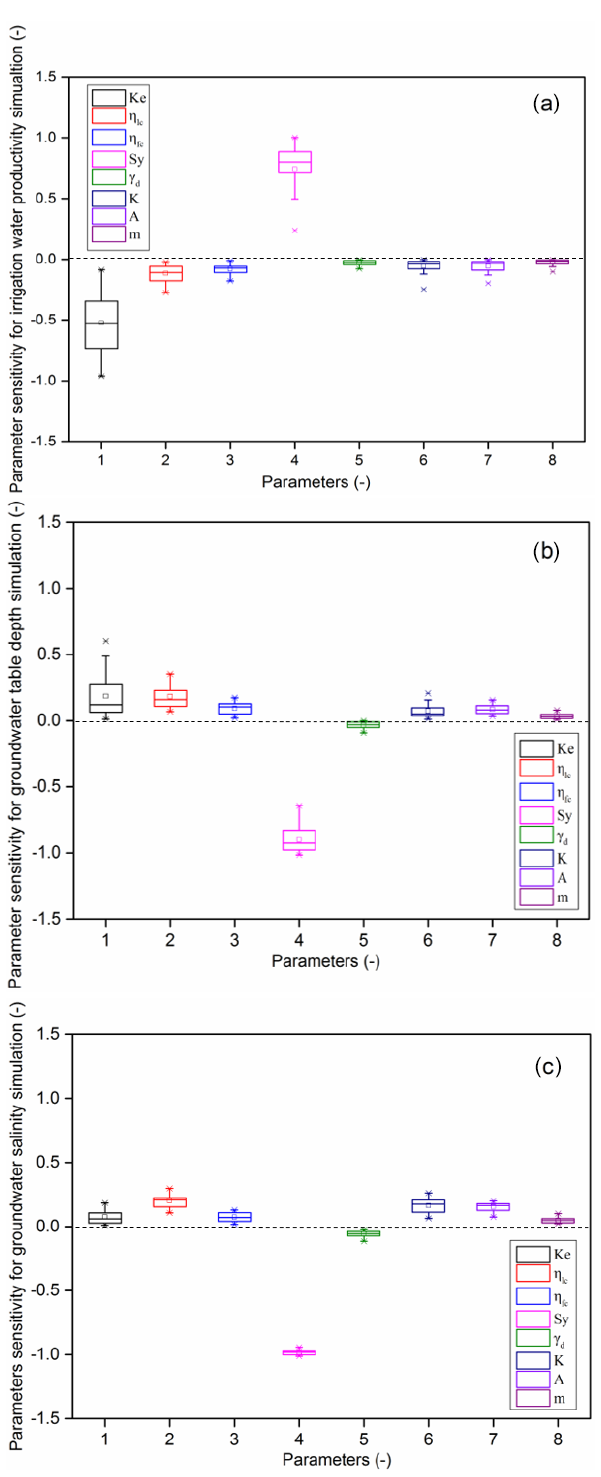
Figure 8. Parameter sensitivity analysis results of the model for the three output variables: (a) irrigation water productivity, (b) ground- water table depth, and (c) groundwater